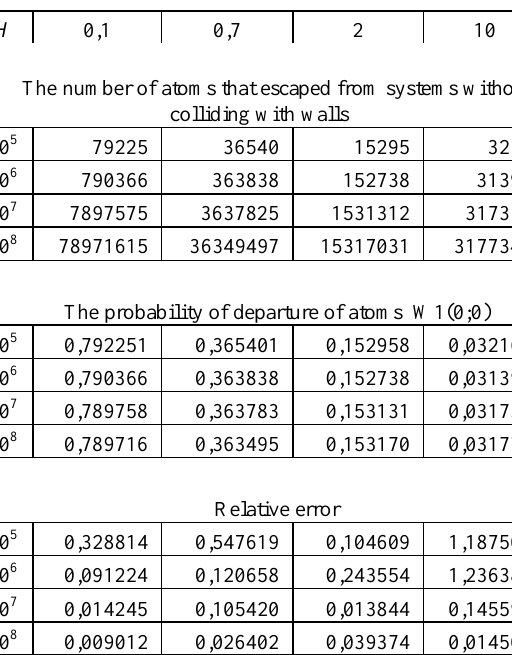
Table 1. The number of atoms ejected from the slot systems and the probability of atom